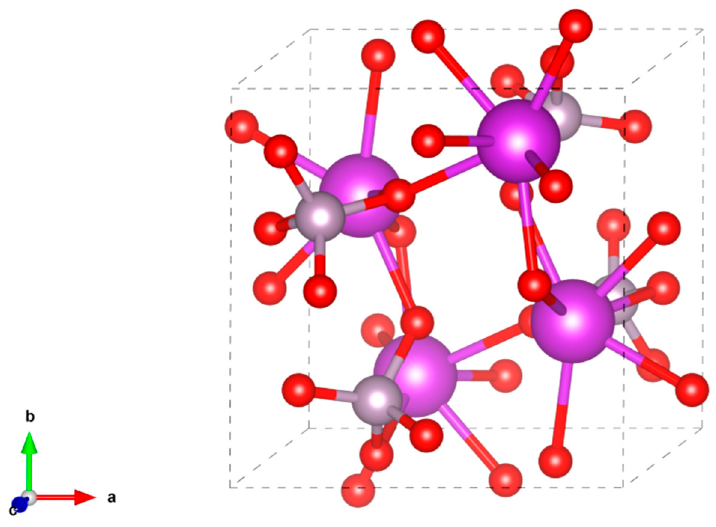
Figure 1. Bulk crystal structure of BiP-500. Purple, gray and red balls represent Bi, P and O atoms, respectively.